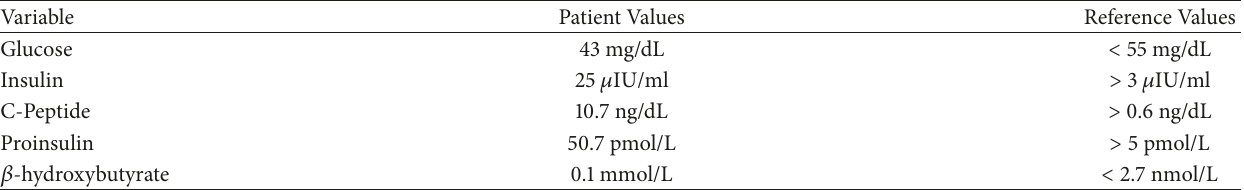
Table 1: Patient’s 𝛽 pancreatic polypeptides and reference values. Reference values from the Endocrine Society Clinical Practice Guidelines for the Evaluation and Management of Adult Hypoglycemic